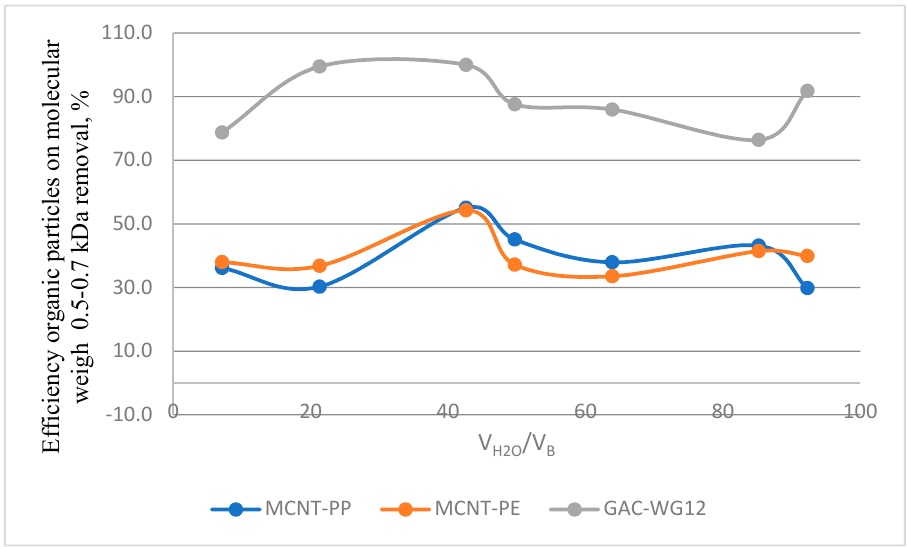
Figure 8. Effectiveness in removing organic substances with molecular weight of 0.5–0.7 kDa. The results that were obtained, and the fact that low and medium molecular weight compounds were removed, are confirmed by studies of effectiveness in removing organic substances that showed that when using carbon nanotubes, humic substances are more effectively removed than fulvic acids